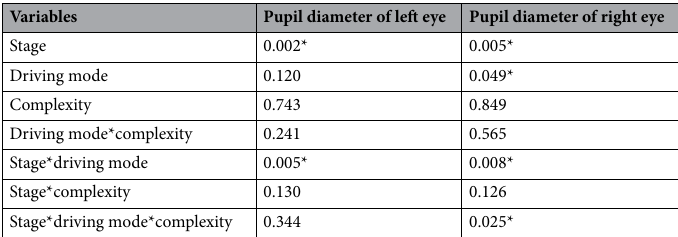
Table 2. A summary table of the ANOVA significance of pupil diameter.